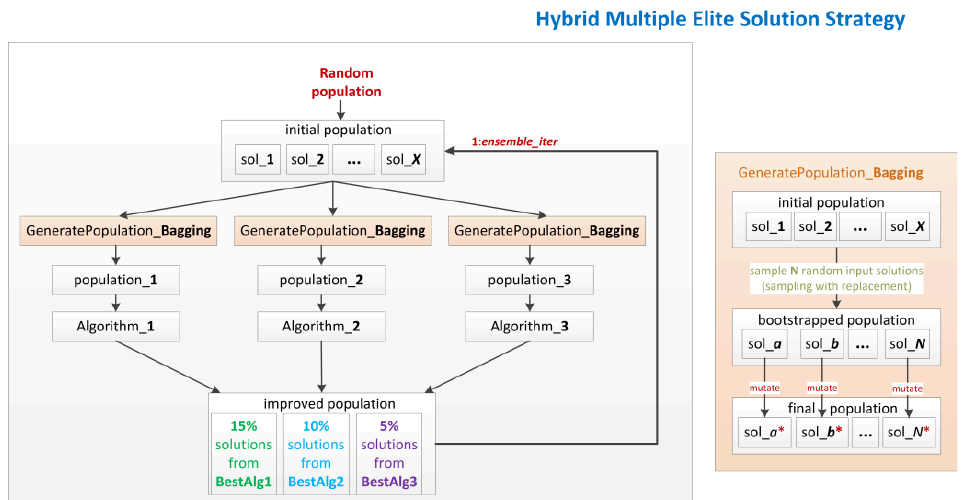
Figure 6. Hybrid multiple elite solutions strategy. For each iteration of the ensemble, the initial population is generated from the improved population of the previous iteration. Starting from the improved population sol_i, i=1..N, an initial population sol_a*, sol_b*, ..., sol_N* is generated for the next ensemble iteration by taking samples sol_a, sol_b, ..., sol_N from sol_i and applying a mutation operator.